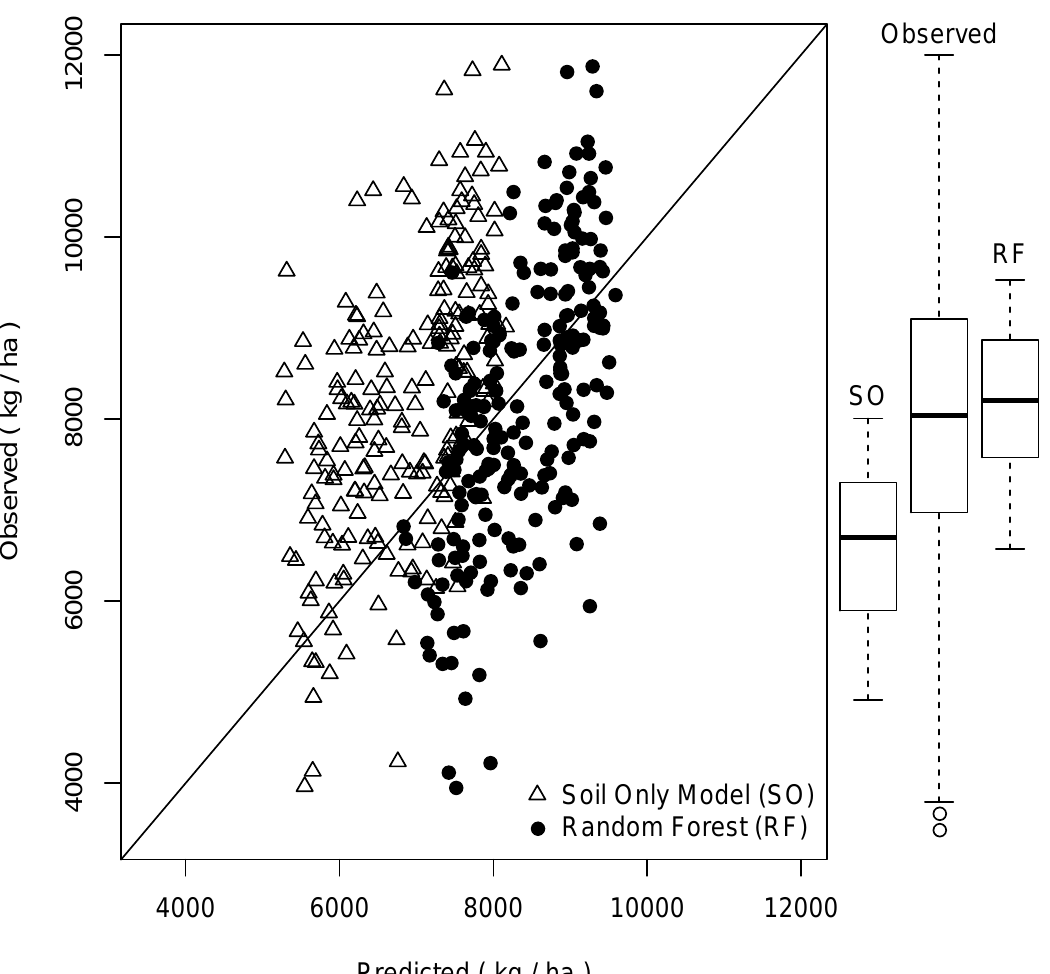
Figure 3. Comparison of the soil-only and random forest models using a random test dataset (n = 219; 25% of